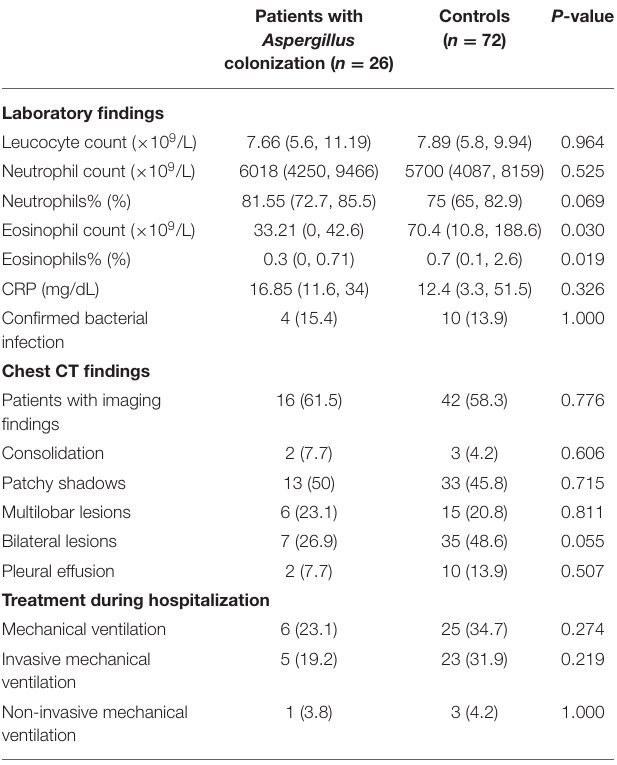
TABLE 3 | Clinical characteristics and treatments of COPD patients on admission with or without Aspergillus colonization. Patients with Aspergillus